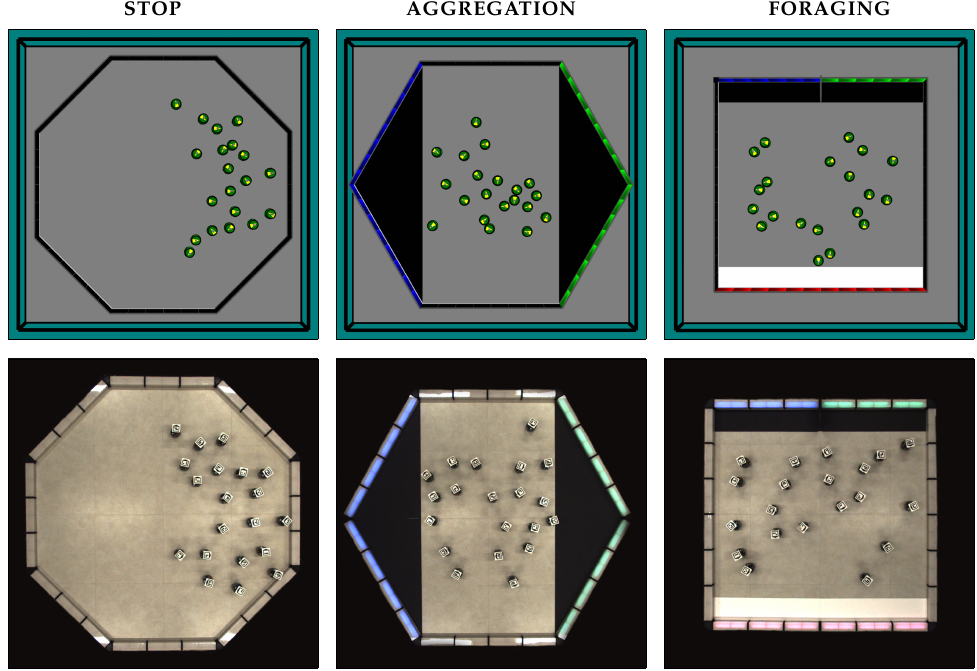
Figure 2. Set-up of the simulated (top) and real arena (bottom) for the missions STOP (left), AGGREGATION (center), and FORAGING (right). The images show an example of the initial position of the